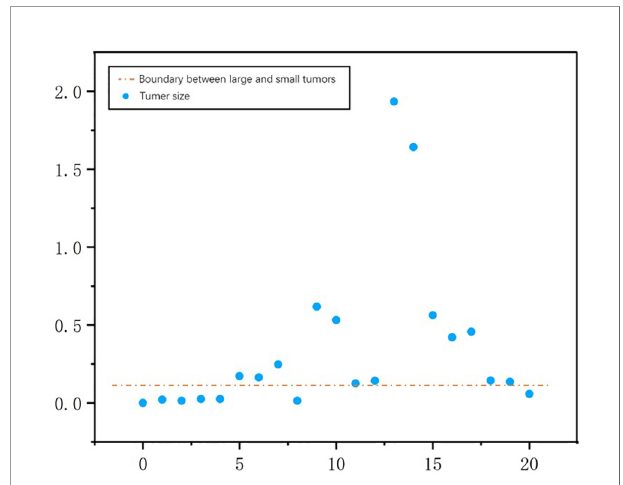
FIGURE 12 | The number of tumor voxels per patient in the test dataset. The orange line was used to distinguish between a large tumor group and a small tumor group.